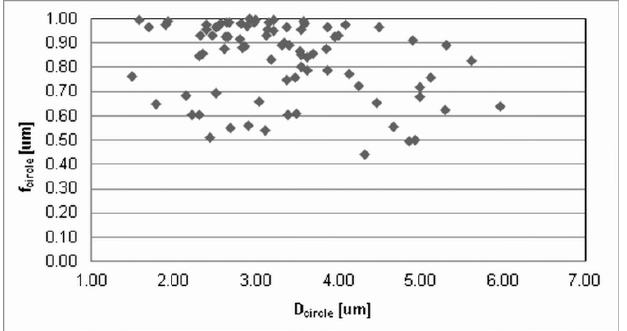
Figure 11. The dimensional and morphological characteristics, f circle , of porosity for ECAPed specimens (400 MPa).